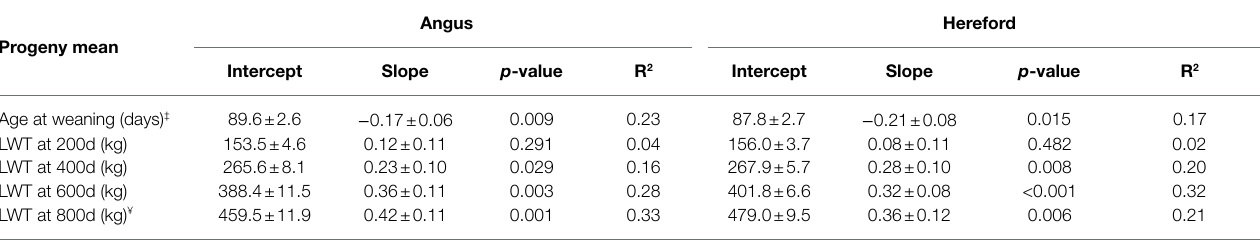
TABLE 4 | Estimates of regression coefficients (intercept and slope) of least-squares means of beef-cross-dairy progeny groups for growth traits (age at weaning and liveweight at 200, 400, 600, and 800 days of age) on corresponding sire EBV for liveweight, for 29 Angus and 34 Hereford sires. Angus Hereford Progeny mean Intercept Slope p -value R 2 Intercept Slope Age at weaning (days)